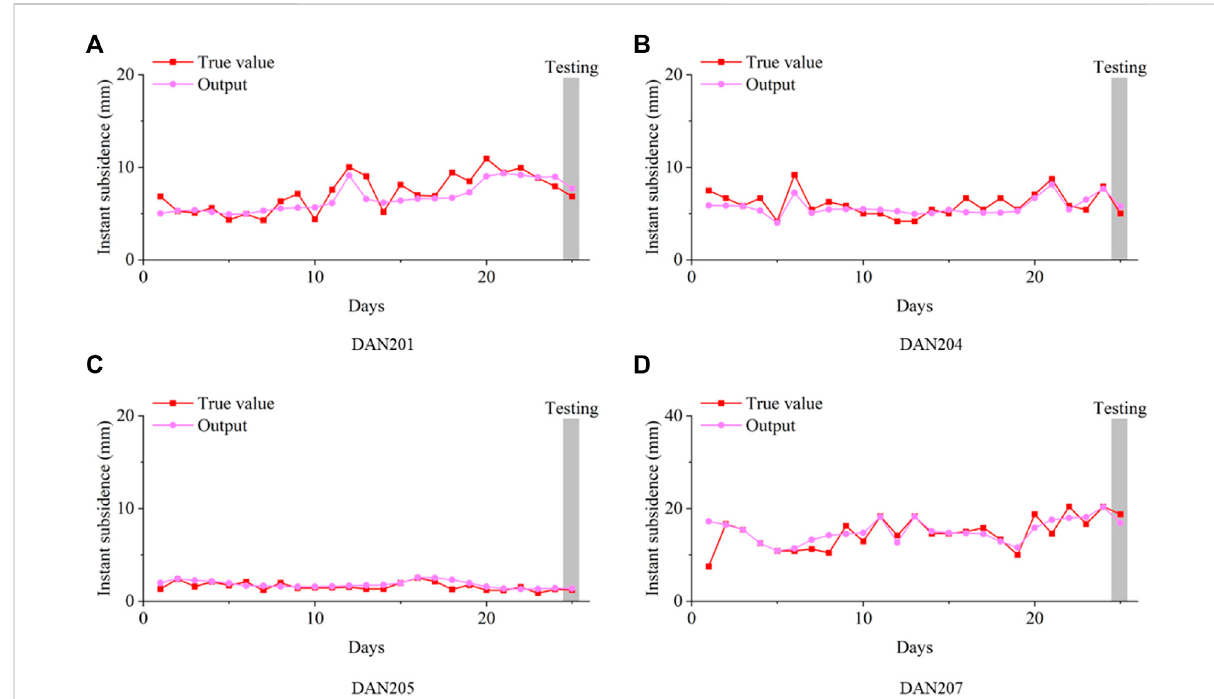
FIGURE 3 1-day ahead prediction of instantaneous subsidence. (A) DAN201, (B) DAN204, (C) DAN205, (D)